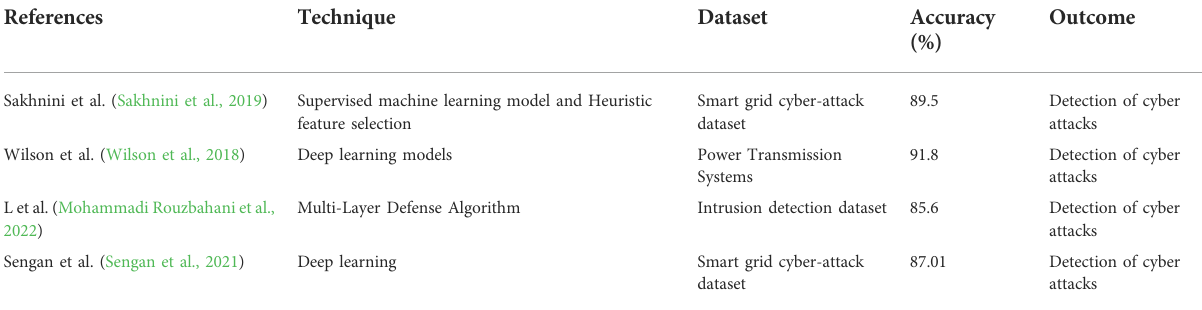
TABLE 1 Comparative of analysis of previous